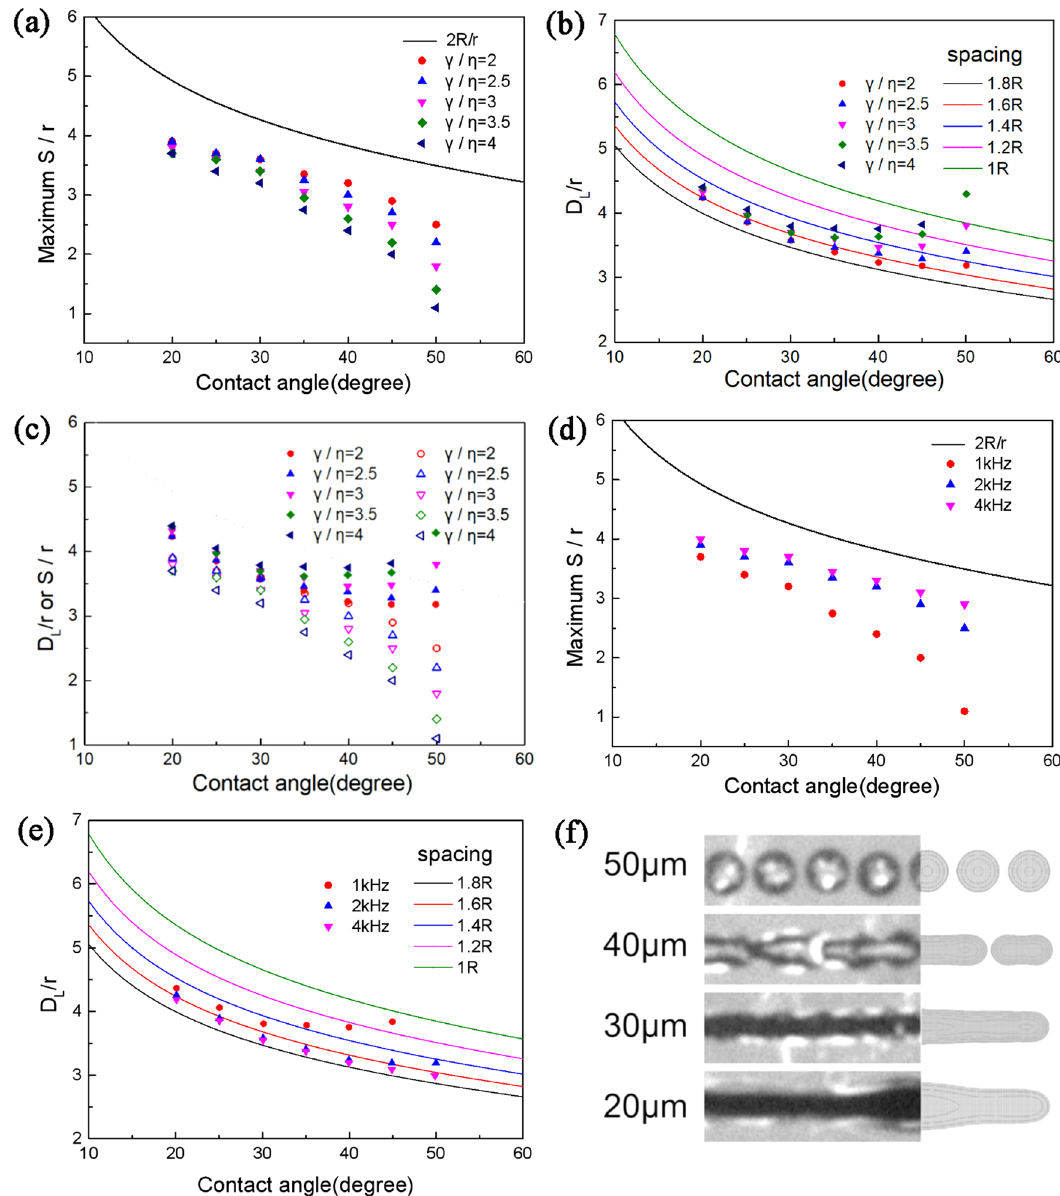
Fig. 7 Results of multi-droplet deposition simulation. a Simulated maximum drop spacing with different γ / η values. b Calculated minimum line width with different γ / η values. c Comparison of the maximum drop spacing and minimum line width. d Simulated maximum drop spacing with different printing frequencies. e Calculated minimum line width with different printing frequencies. f Real printed droplets and corresponding simulated results. In a , points represent maximum drop spacing to form continuous printed line for different conditions, and shows that small γ / η results in larger maximum spacing. b Shows the minimum width of lines in different conditions, this fi gure shows that 30 – 40° are proper contact angle for fabricating thinner lines. c Is a mixture of a and b , this fi gure is made to see whether the maximum spacing can be used to print sheet patterns. d and e are just like a and b , but the γ / η is fi xed ( γ / η = 2) and printing frequency is neighboring droplets and form continuous lines. The distinction of shows the minimum D L / r of different cases. When θ s < 30°, a larger the results between f p = 2 kHz and f p = 4 kHz is not very obvious, R results in a larger D L . When θ s > 40°, droplets easily aggregate, and a smaller S is necessary to form a continuous line; thus, D L so f p = 2 kHz is suf fi cient for most conditions. The simulation results of cases with γ / η = 2 and f p = 1 kHz are extremely similar to becomes larger. Therefore, 30° < θ s < 40° is appropriate for fabricating thin single lines. Figure 7c draws the points in Fig. 7a those of cases with γ / η = 4 and f p = 2 kHz, which can be explained and b together. Because the minimum D L / r is larger than the by the moving distance of the contact line. As discussed above, v contline with γ / η = 4 is twice that with γ / η = 2 at every transition maximum S / r , these printing parameters can be used for fabricating patterns with multirow lines. state, so it takes half the time for cases with γ / η = 4 to obtain a Figure 7d and e show the simulated results of cases with γ / η = 2 similar shape. In summary, ( γ / η )/ f p is decisive in multi-droplets and different f p , and the maximum S / r increases with f p . Because simulation, and a lower ( γ / η )/ f p is bene fi cial for improving the contact lines move a shorter distance during the interval time pattern quality. Consider the scale factor, real required f p could be with higher f p values, droplets have more chance to contact 1/ f R in the simulated case.